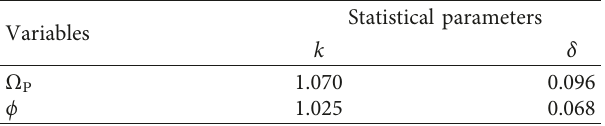
Table 2: Statistical parameters of resistance for stability calculation of axial compression